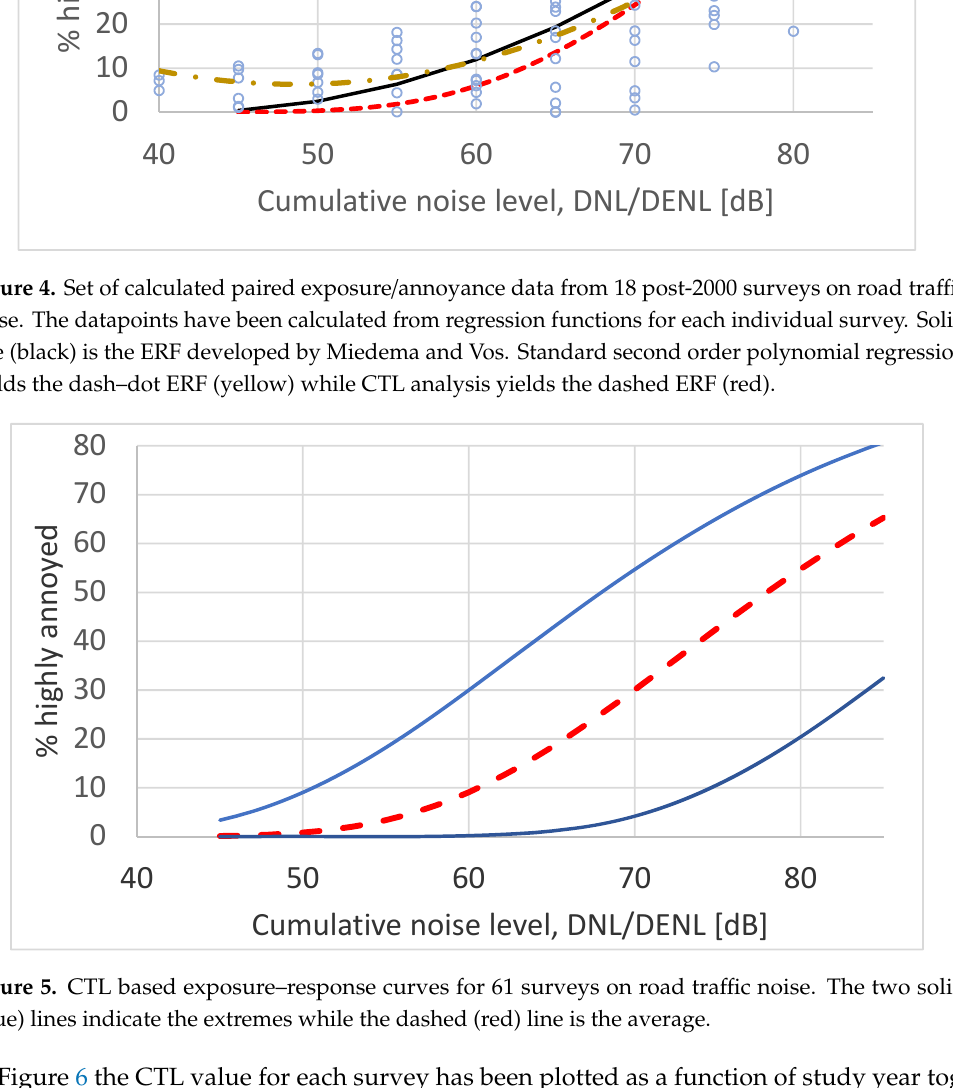
(blue) lines indicate the extremes while the dashed (red) line is the average.